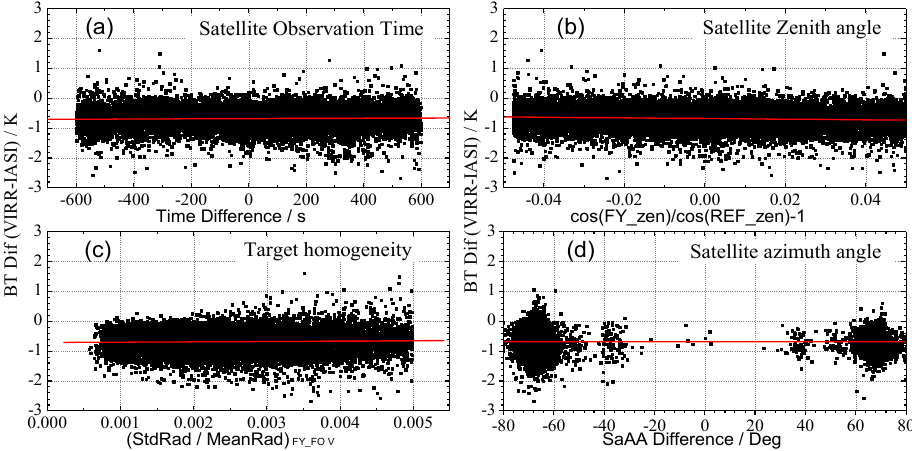
Figure 5. Scatterplots of BT differences between FY-3B/VIRR channel 4 and IASI varying with observation time difference ( a ); satellite zenith angle ( b ); target homogeneity ( c ); and satellite azimuth angle ( d ) based on collocated samples from August to December in 2012 (Solid lines are linear fitting results).